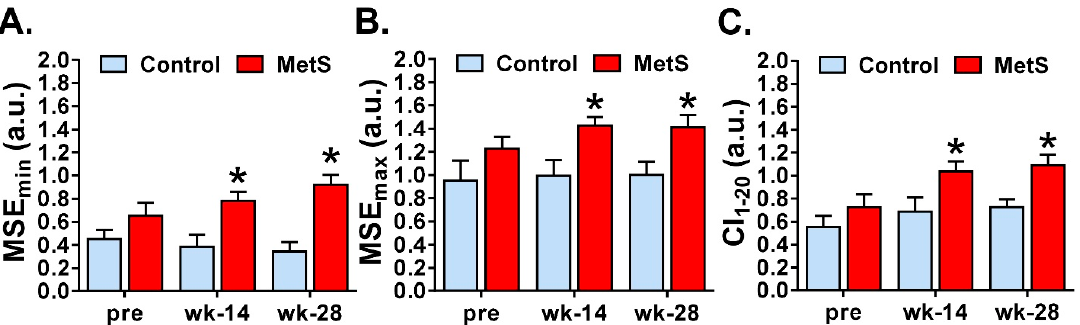
Figure 3. Multiscale entropy analysis of short-term HRV. Quantification of the minimum and maximum multiscale entropy (MSE min and MSE max ) is shown in panels ( A ) and ( B ) respectively. The quantification of complexity index (CI 1–20 ) is depicted in panel ( C ) Control n = 9, MetS n = 13. * p < 0.05 vs control. Error bars: SEM.